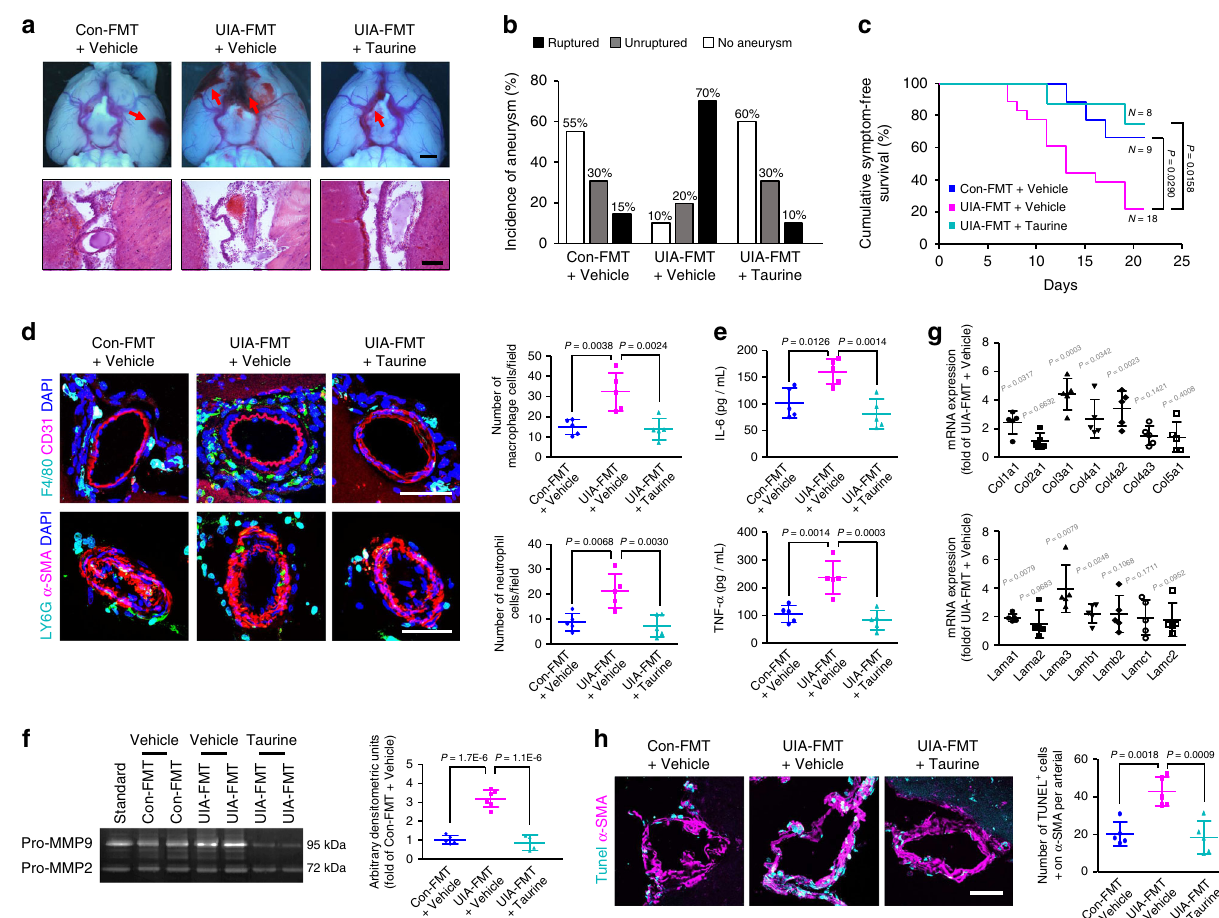
Fig. 6 Taurine reduces the incidence of intracranial aneurysms. a Representative images of intracranial aneurysms (upper; arrows, intracranial aneurysms; scale bar, 1 mm) and cerebral arteries stained with hematoxylin-eosin (lower; scale bar, 100 μ m) in mice that received fecal microbiota transplantation (FMT) from UIA patients or controls, followed by taurine supplementation and aneurysm induction with angiotensin II and elastase. Independent experiments were repeated at least fi ve times. b Incidence of unruptured and ruptured aneurysms 21 days after aneurysm induction ( n = 20). c Cumulative symptom-free curves for mice with aneurysms to show the time course of symptom onset ( n = 9 for control-FMT + Vehicle group, n = 18 for UIA-FMT + Vehicle group, n = 8 for UIA-FMT + Taurine group; log-rank (Mantel – Cox) test). d Upper panels, representative images and quanti fi cation of F4/80 + macrophage immunostaining surrounding CD31 + cerebral vessels. Lower panels; representative images and quanti fi cation of Ly6G + neutrophil immunostaining surrounding α -SMA + cerebral vessels (scale bars, 50 μ m). e Levels of IL-6 and TNF- α in serum measured by ELISA. f Representative gelatin zymography and quantitative analysis of the MMP-9 activity in cerebral vessels from each group ( n = 6; one-way ANOVA with the Bonferroni post hoc test). g Quantitative PCR showing the expression of pivotal components of arterial structure ( n = 5; Student ’ s unpaired two-tailed t-test